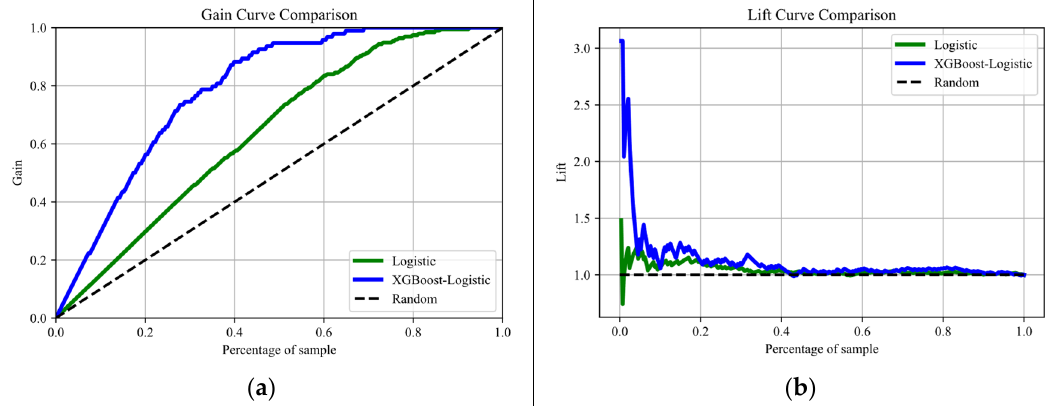
Figure 13. Performance comparison and analysis of the model. ( a ) Gain curve comparison; ( b ) lift curve comparison.